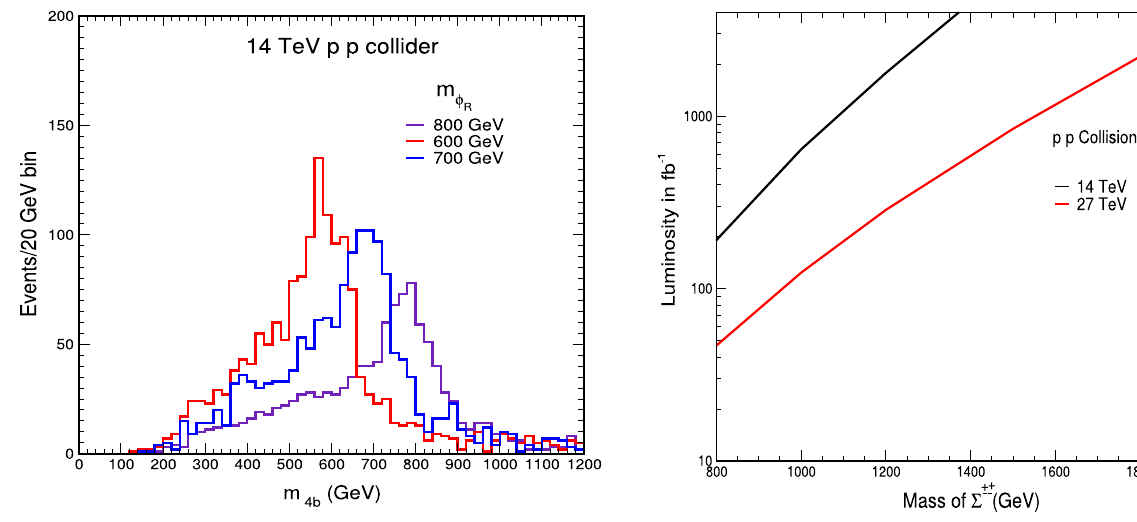
Fig. 6 The four b-jet invariant mass distribution in events of pp → Z /γ → (cid:4) ++ (cid:4) −− at 14 TeV for different masses of ϕ R Table 3 Number of expected events at 150 f b − 1 , 300 f b − 1 and 3000 f b − 1 at 14 TeV p-p collision in different channels M ϕ (GeV) R